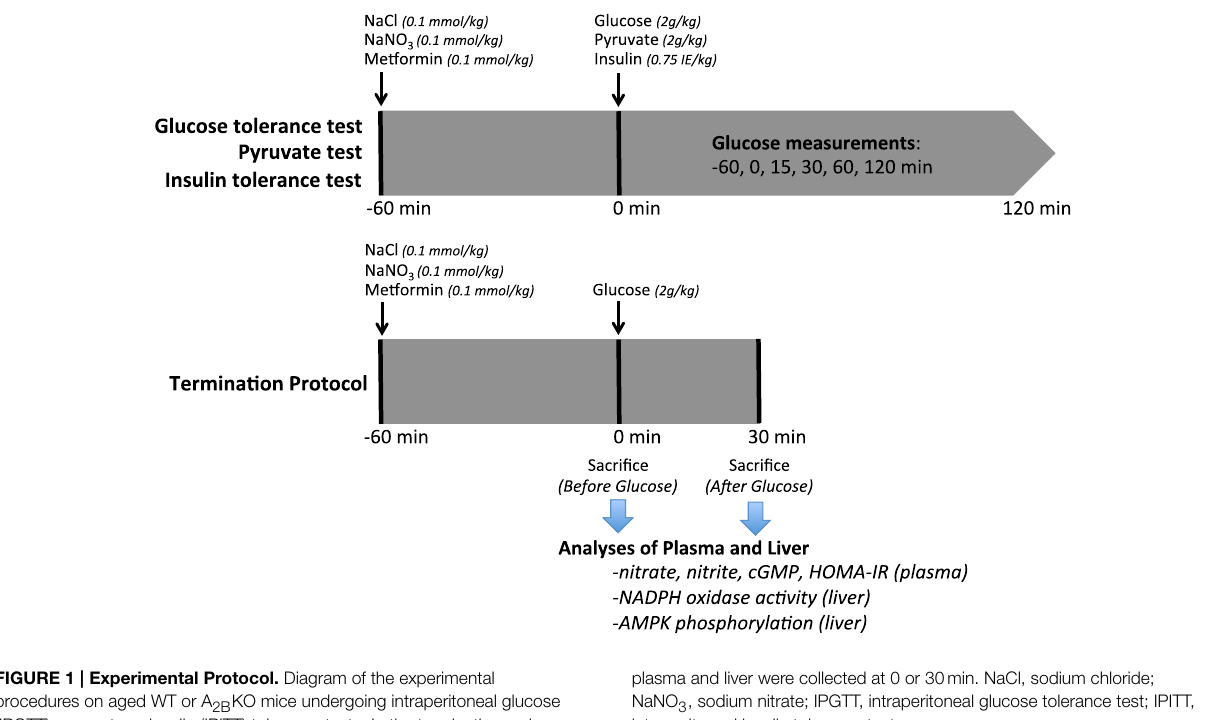
FIGURE 1 | Experimental Protocol. Diagram of the experimental procedures on aged WT or A 2B KO mice undergoing intraperitoneal glucose (IPGTT), pyruvate or insulin (IPITT) tolerance tests. In the termination series,